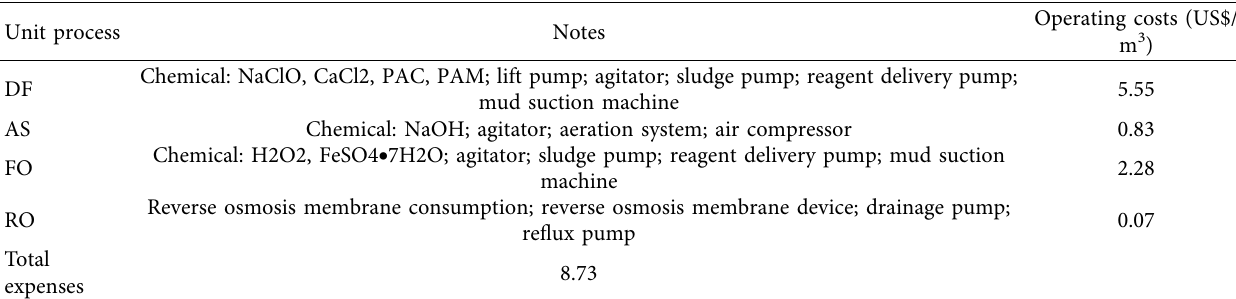
Figure 9: GC-MS total ion chromatogram (TIC) of thermal desorption raw wastewater and Fenton oxidation (FO) effluent. Table 3: Operating cost